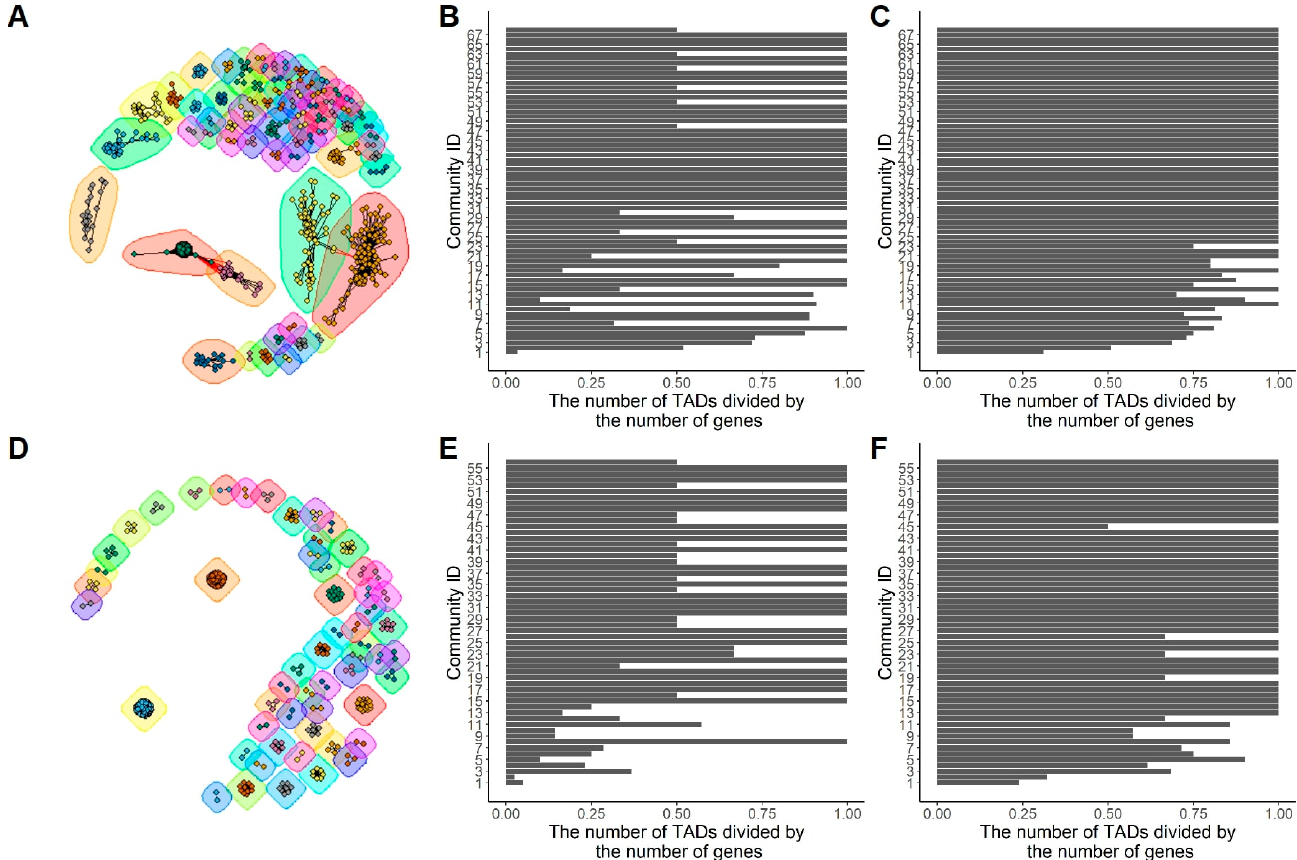
Figure 4. The network communities for BPO FSNs of mouse chromosome 2. ( A , D ) show the network communities with functional thresholds 0.7 and 1, respectively. ( B , E ) show the distributions of the same ‐ TAD ‐ belonging ratios. ( C , F ) show the distributions of the same ‐ TAD ‐ belonging ratios based on random communities.